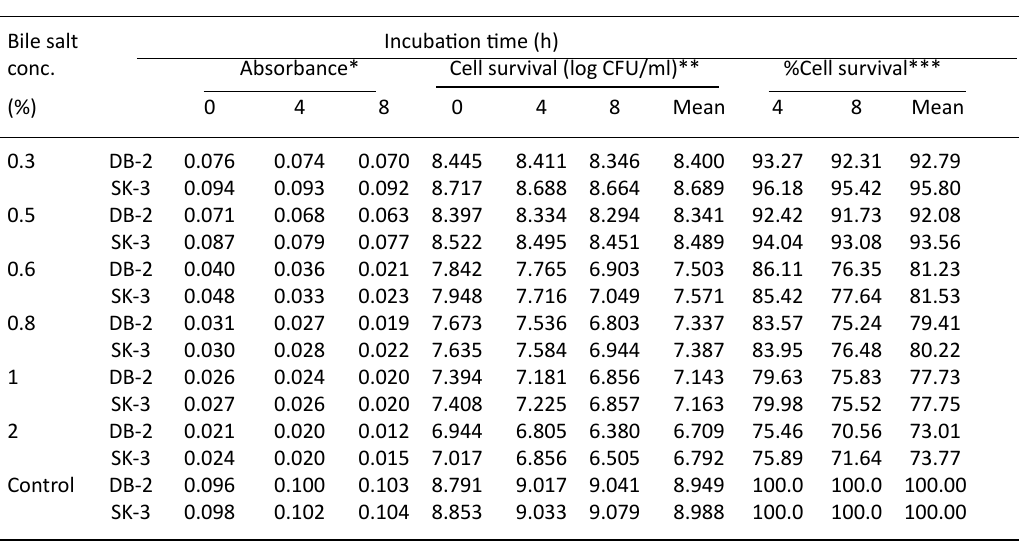
Table 4. Bile tolerance of L. plantarum DB-2 & SK-3 Bile salt Incubation time (h) conc. Absorbance*